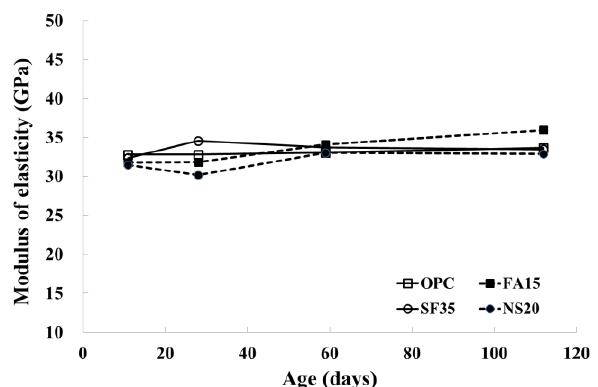
Figure 3. Elastic modulus vs. age.